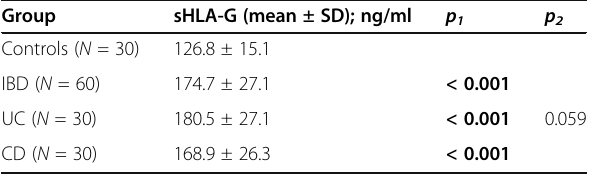
Table 2 Serum level of soluble HLA-G antigens in inflammatory bowel disease (ulcerative colitis and Crohn's disease) patients and